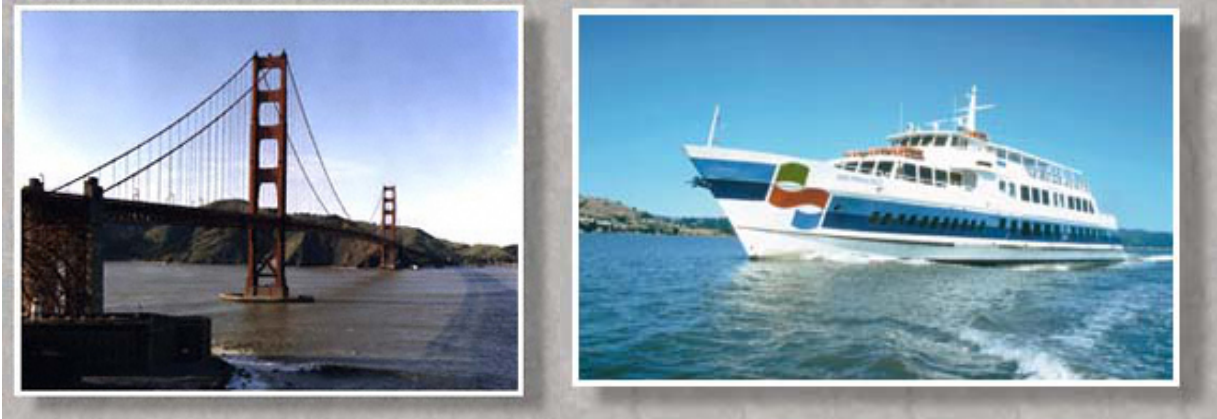
Figure 1. Golden Gate Bridge and Golden Gate Ferry